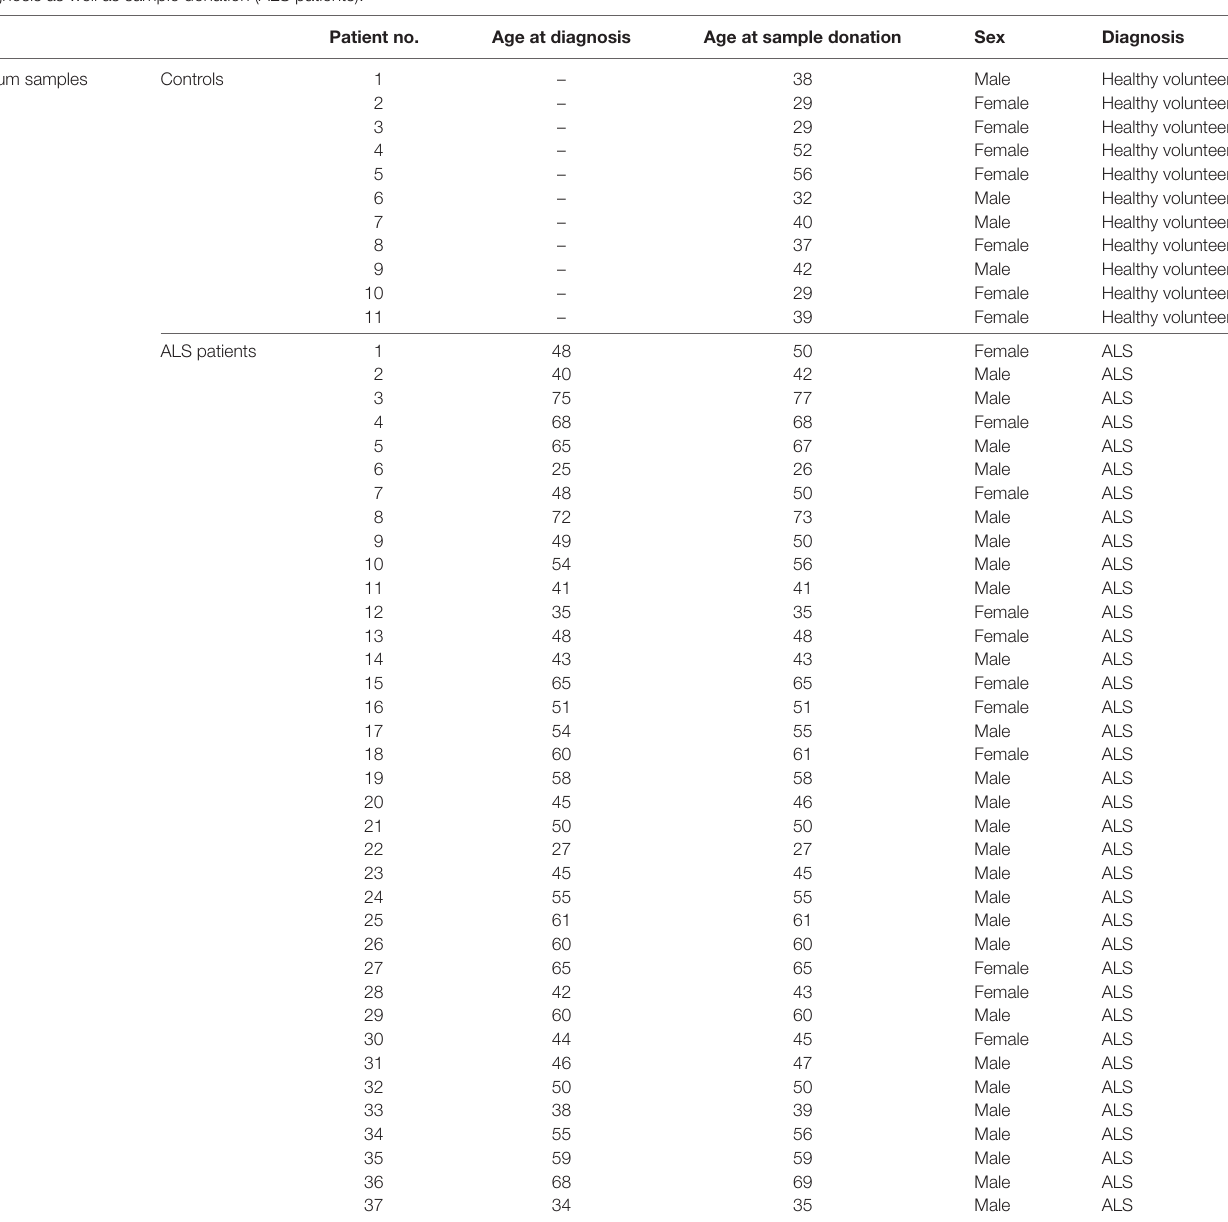
Table 1 | Characteristics of controls and ALS patients for the analysis of sera with the individual ages on the date of measurement (healthy volunteers) and the ages at diagnosis as well as sample donation (ALS patients). Patient no. age at diagnosis age at sample donation sex Diagnosis Serum samples